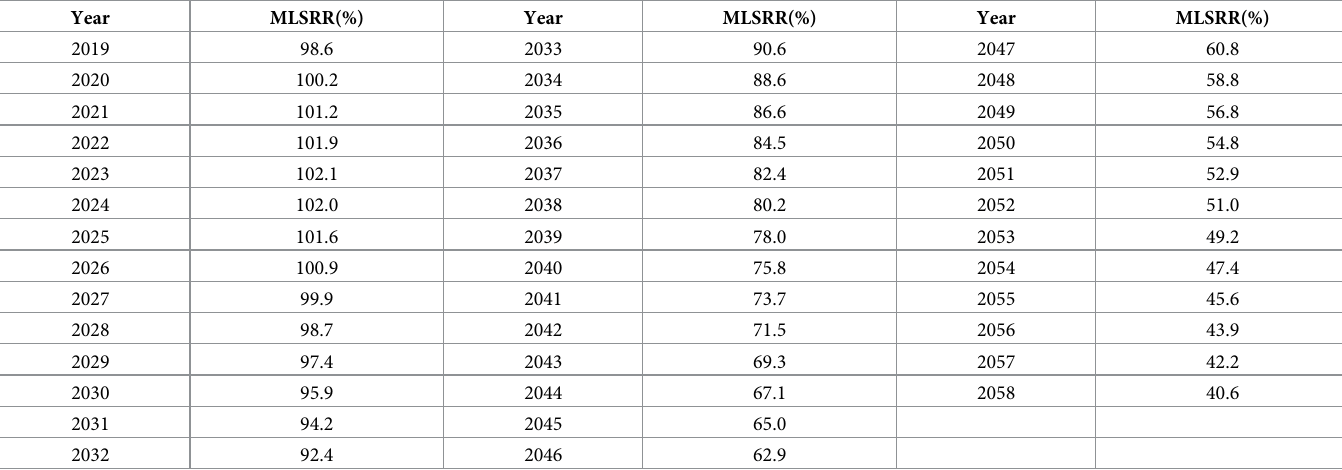
Table 6. The prediction results of the modified living standards replacement rate (MLSRR) for the elderly from 2017 to 2058.